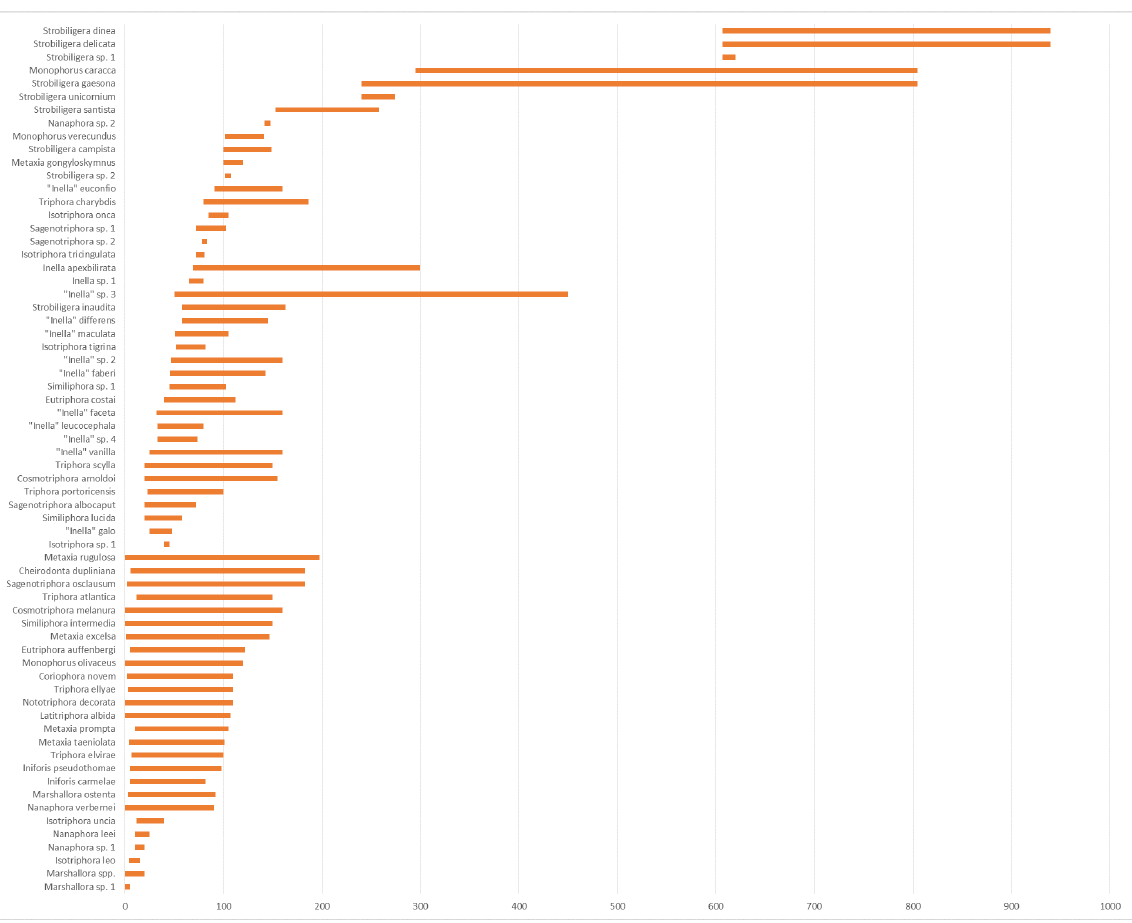
Fig. 85. Bathymetric range of triphorids from